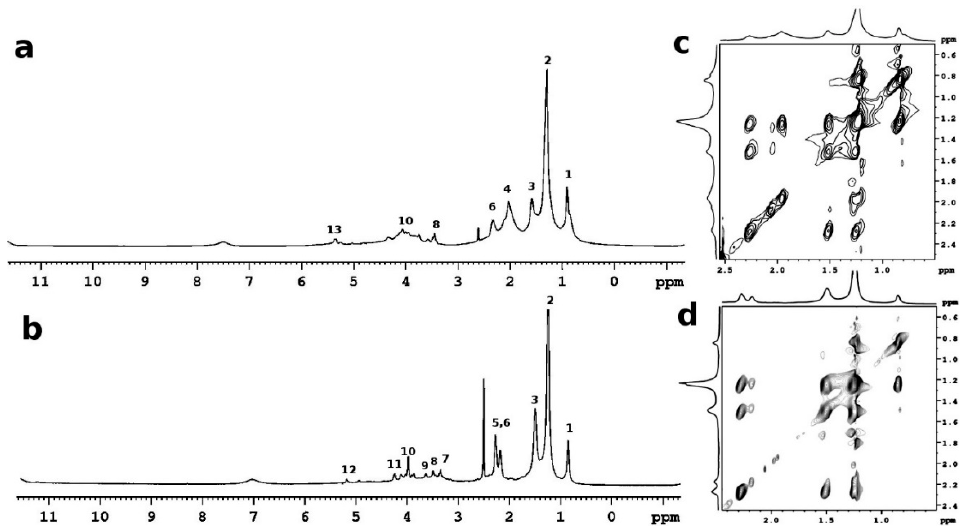
Figure 5. 1 H HR-MAS NMR spectra (d6-DMSO δ = 2.55 ppm, H 2 O in DMSO δ = 3.33 ppm) of ( a ) model paint sample linseed oil with lead carbonate (1:1) naturally aged for 10 years; ( b ) oil wall painting (17th century); ( c ) 1 H- 1 H TOCSY of the oil model paint sample; ( d ) 1 H- 1 H TOCSY of the oil wall painting (17th century) sample. Peak numbers according to Table 2. Table 2. Chemical Shifts ( δ ) assignment in 1 H HR-MAS spectra reported in Figure 5. δ (ppm)